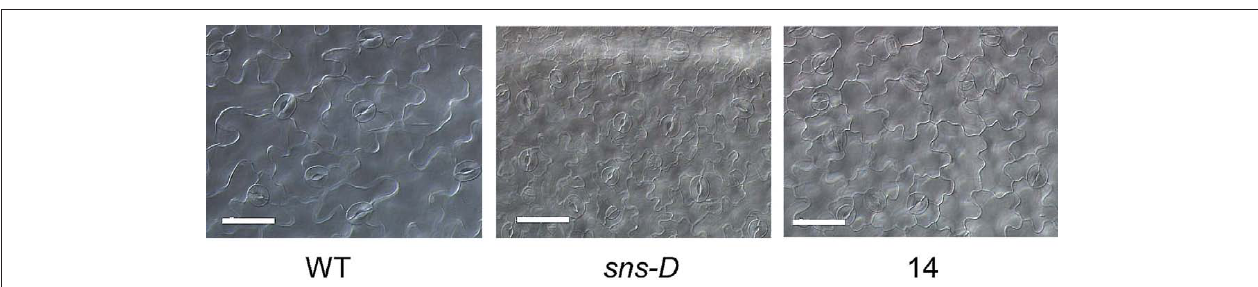
FIgURe 8 | Adaxial sides of leaves of a wild-type plant (WT), the sns-D mutant ( sns-D ), and an overexpression line (14). The bars are